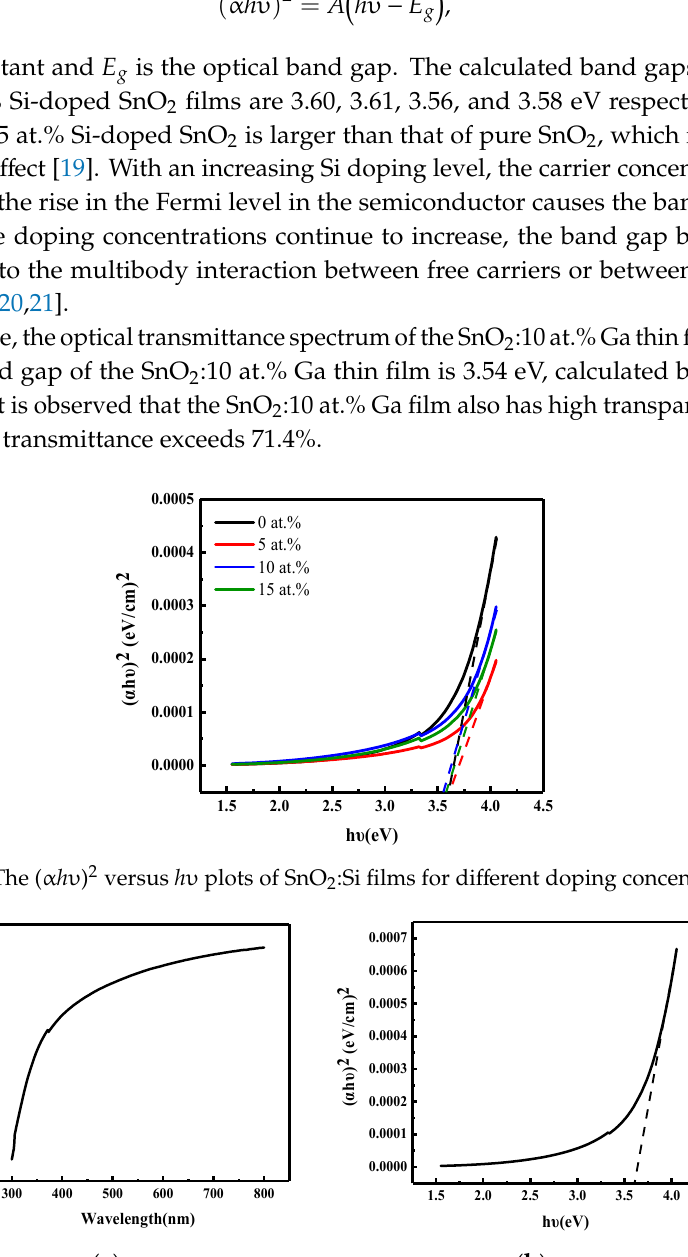
Table 1. Optical parameters of SnO 2 :Si thin films with different Si doping concentrations. Si Doping Concentrations Transmittance (at 560 nm) (%)